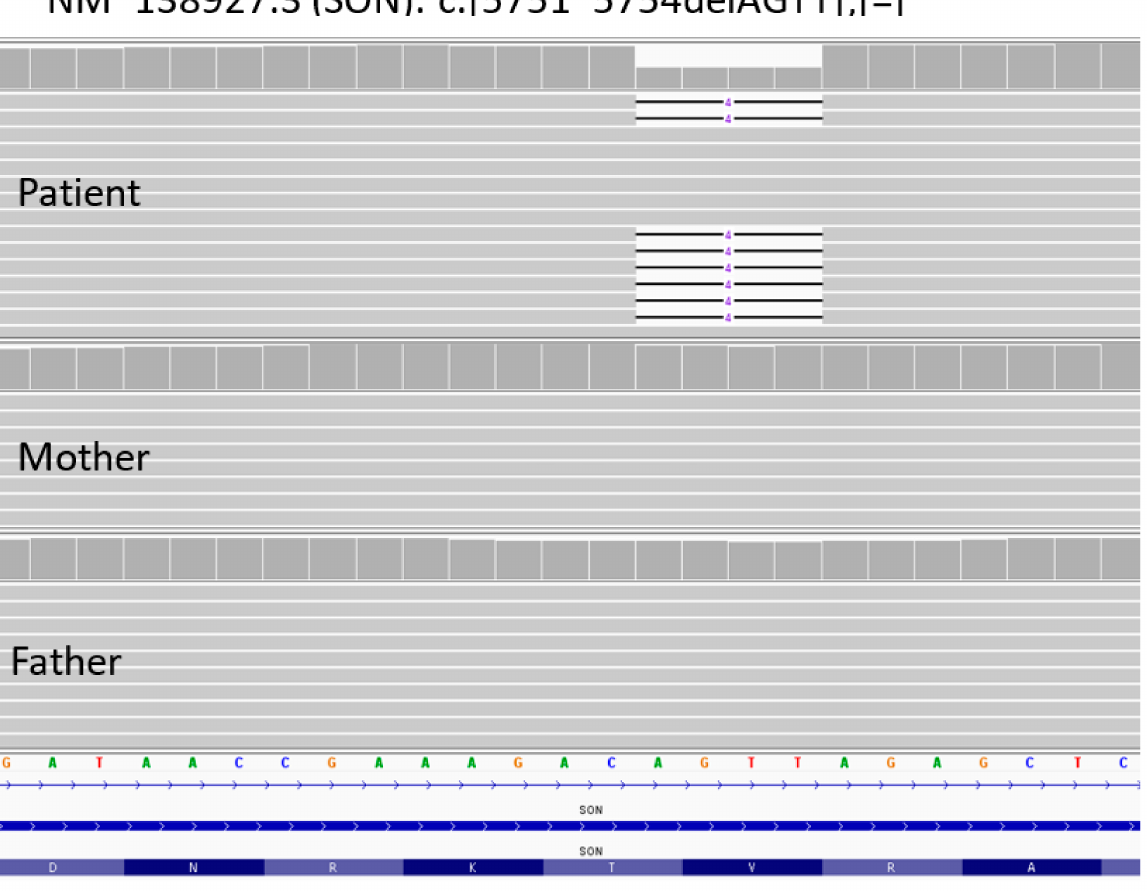
Figure 4. NGS sequencing data from blood samples of the proband and his parents. Identification of de novo variant c.5751_5754delAGTT (p.Val1918fsTer87) in SON